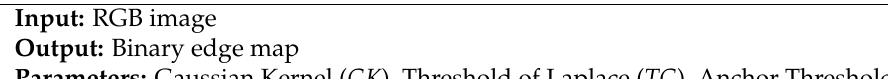
Algorithm 7 Edge Drawing Operator